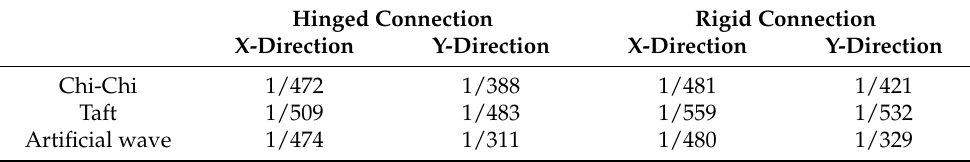
Table 11. Peak interstory displacement angle under the action of rare earthquakes.